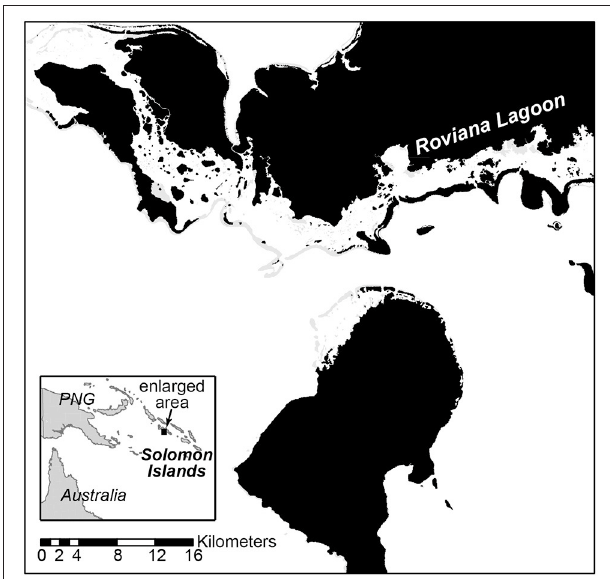
FIGURE 2 | Map of Solomon Islands (Western Province) and research